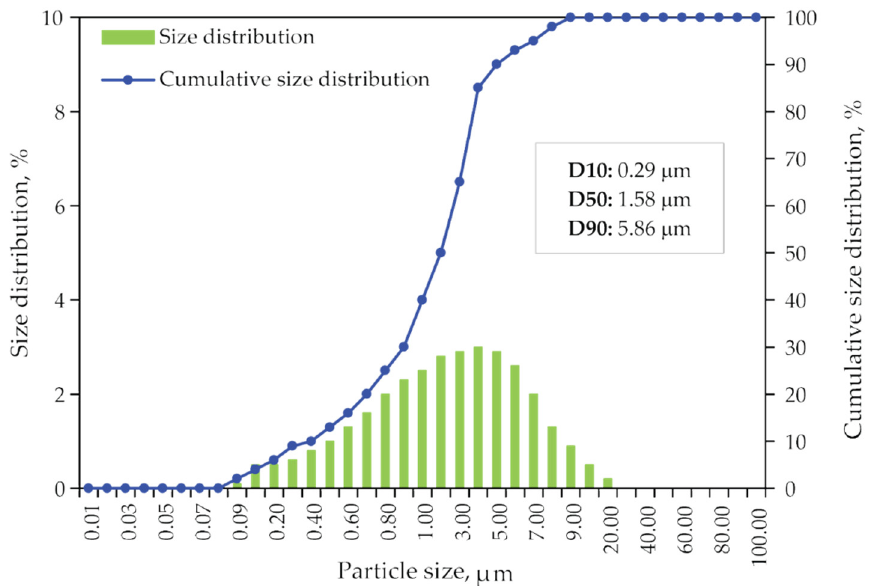
Figure 6. Particle size distribution and the cumulative size distribution of jarosite-PbAg sludge.